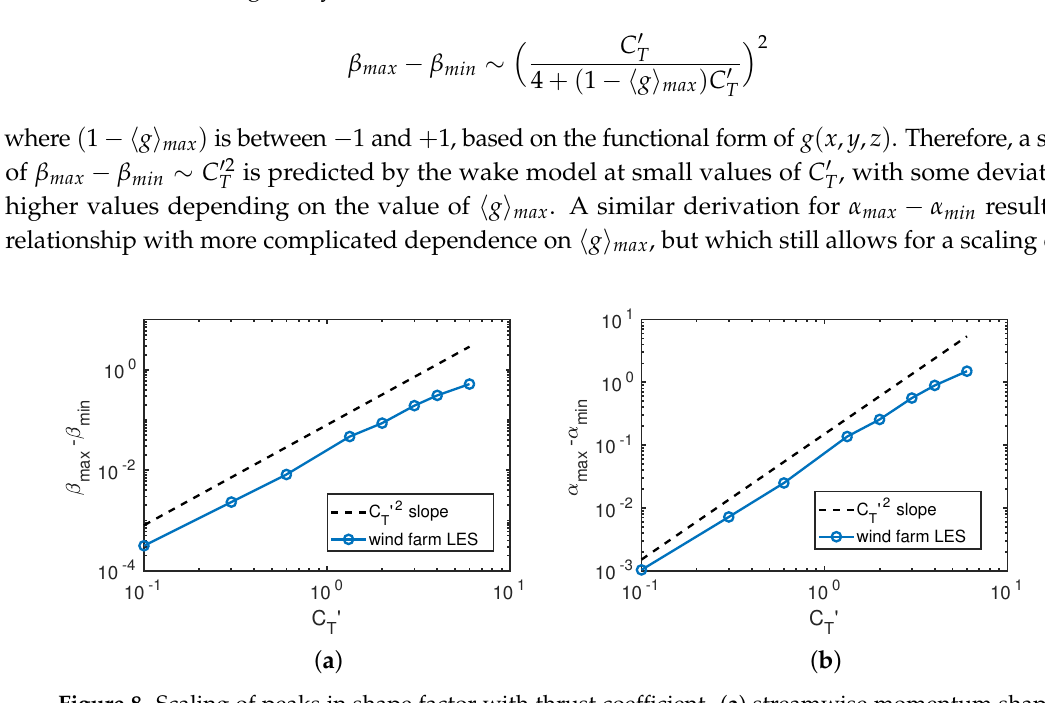
Figure 8. Scaling of peaks in shape factor with thrust coefficient. ( a ) streamwise momentum shape factor. ( b ) mean kinetic energy (MKE) shape factor.